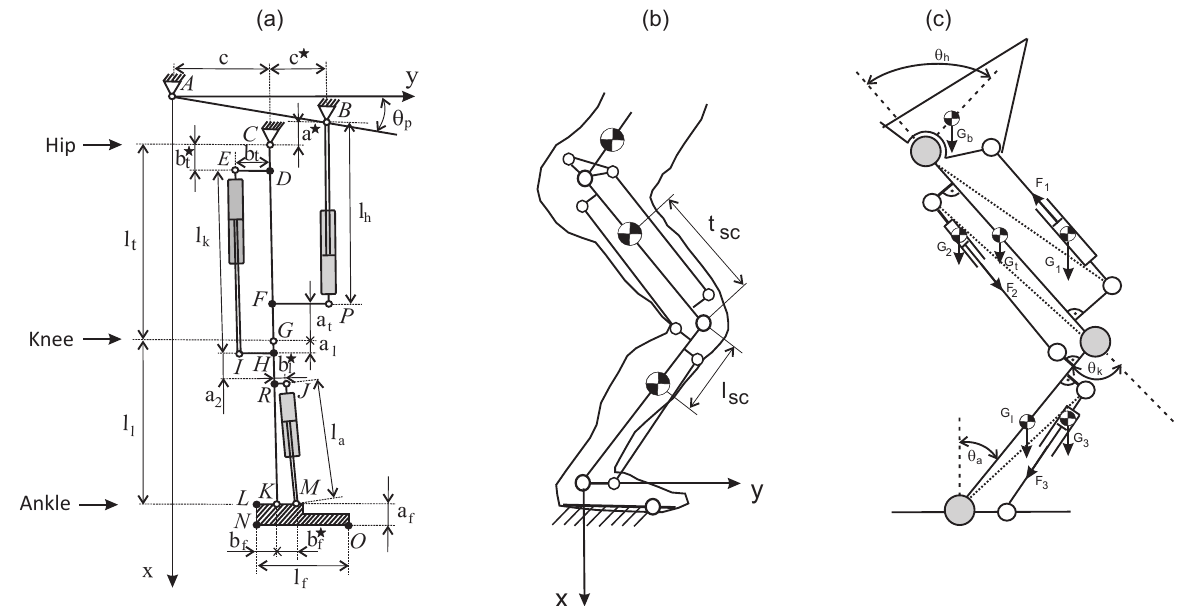
Figure 1. Scheme of the hydraulic exoskeleton in the sagittal plane ( a ), knee bending of the model ( b ), force distribution in hydraulic exoskeleton during knee bending ( c